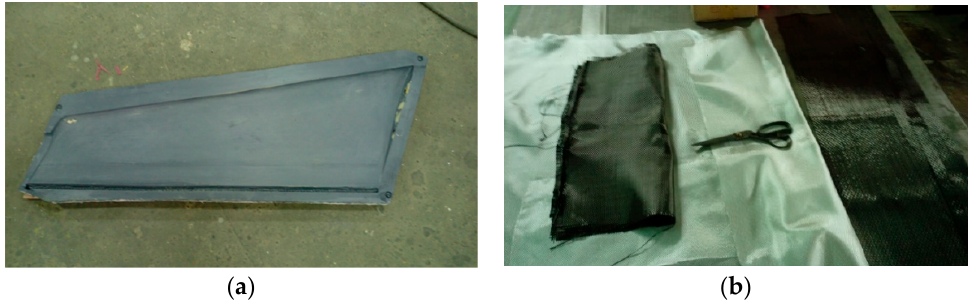
Figure 10. ( a ) Mold of the wing and ( b ) glass fiber and carbon fiber.